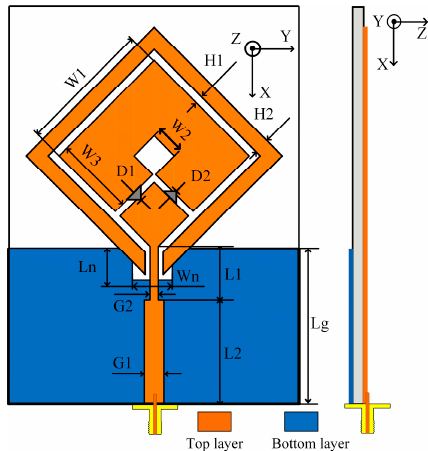
Figure 2. Geometry of the proposed antenna with W 1 = 26, W 2 = 5.5, W 3 = 15.35, L g = 26, H 1 = 1.5, H 2 = 2.75, L 1 = 10.4, L 2 = 16.9, G 1 = 3.8, G 2 = 1.6, W n = 7, and L n = 1 (unit: mm).